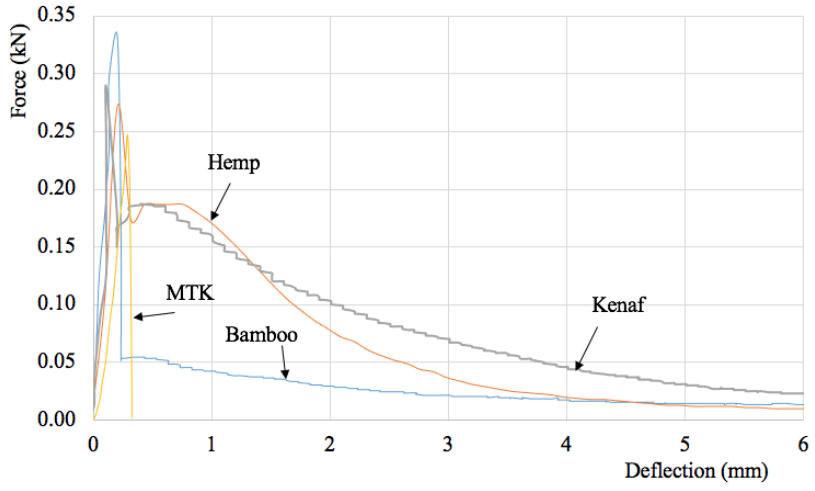
Figure 7. Force vs. displacement for 3 wt% samples and the unmodified matrix.